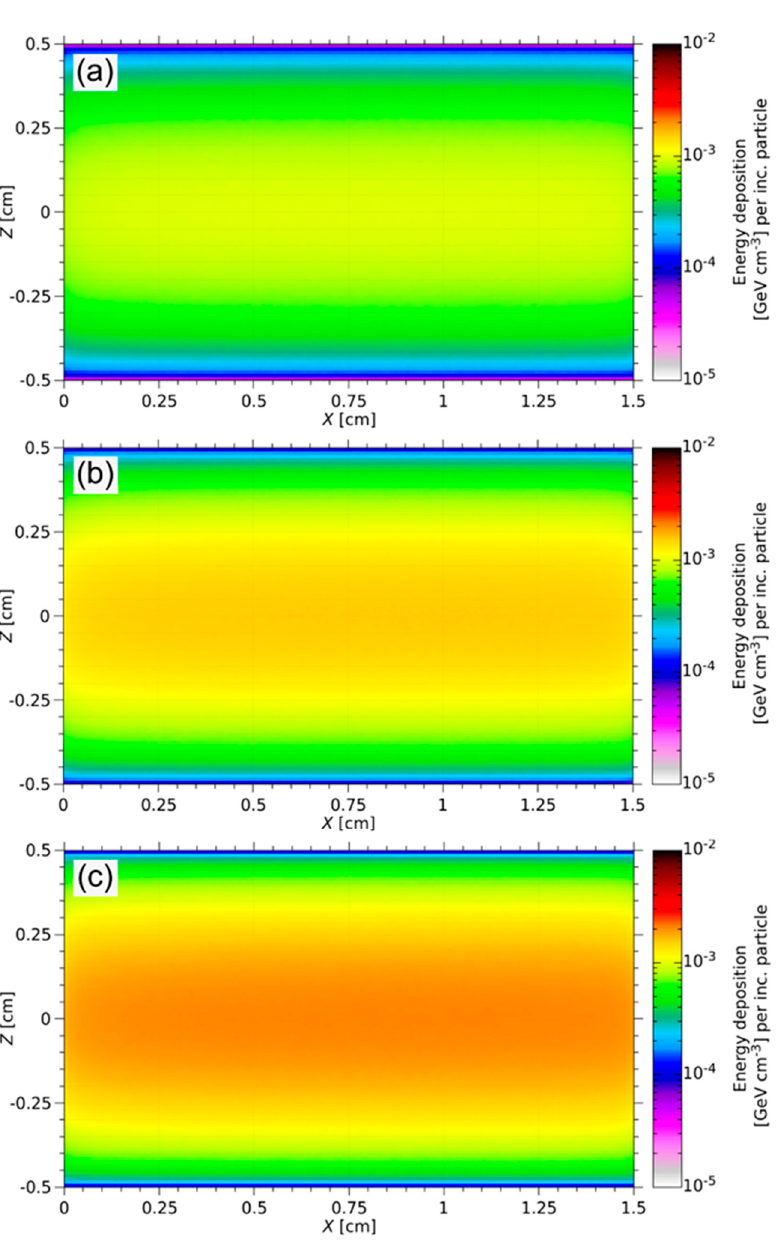
Figure 8. FLUKA simulation of the energy deposition in three different Y 2 O 3 targets with 10 vol% ( a ), 15 vol% ( b ), and 20 vol% ( c ) solid loading for the ISOLDE beam. The FLUKA results are normalized per incoming particle (per inc. particle). The maximum energy deposited along the long axis of the cylinder is 1.68 ×10 -3 GeV cm − 3 per inc. particle ( a ), 2.58 ×10 -3 GeV cm − 3 per inc. particle ( b ), and 3.37 × 10 -3 GeV cm − 3 per inc. particle ( c ).